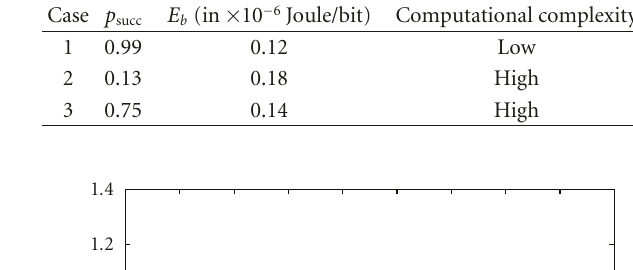
Table 1: Comparison of routing schemes with di ff erent interference models.